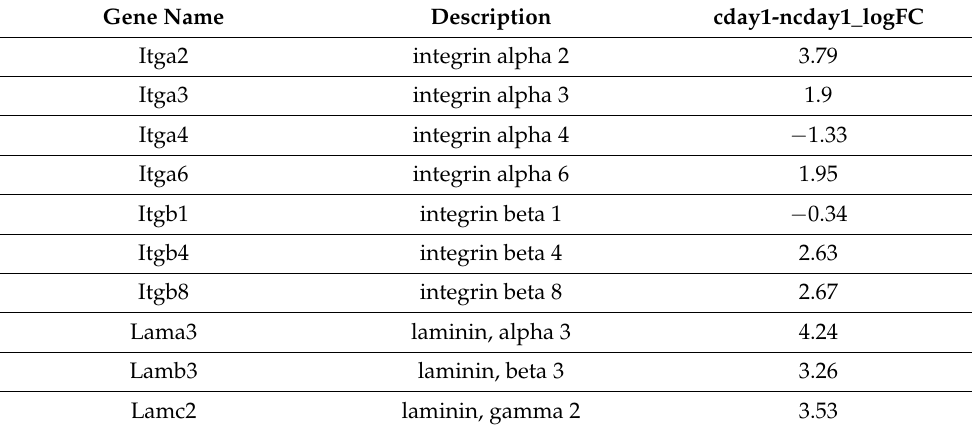
Table 5. Expression of laminins and integrins in chronic